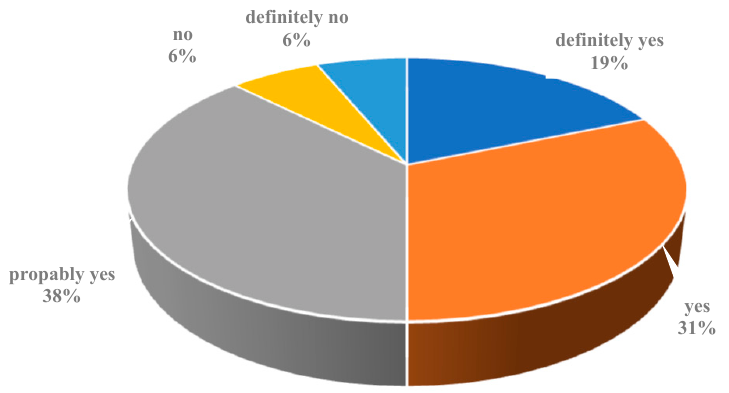
Figure 5. Assessment of the spatial design of the crosswalk in terms of safety. The five-star intersections have been characterized in terms of the factors specified in the standard, as shown in Table 2. At the busiest intersections (average result of respondents’ answers), street lighting was included in the Intelligent Lighting system implemented in Szczecin. In the case of intersections with two-lane, two-way roads, islands separating the lanes (and sometimes tram tracks) are used. According to the respondents, the visibility at selected intersections is not satisfactory during the day, while at night better visibility was at intersections